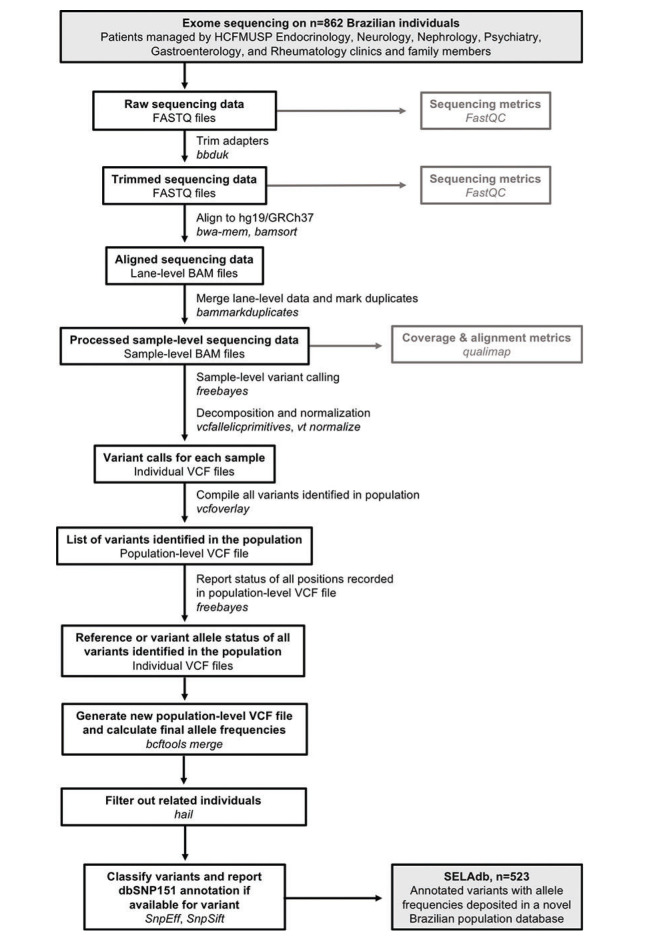
Flow chart of data processing steps used to generate SELAdb database.